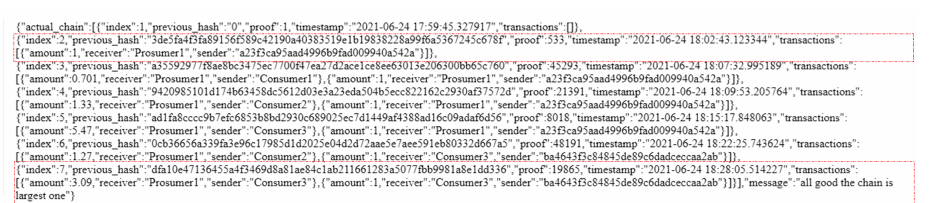
Figure A11. Sender and receiver amount digits in an actual